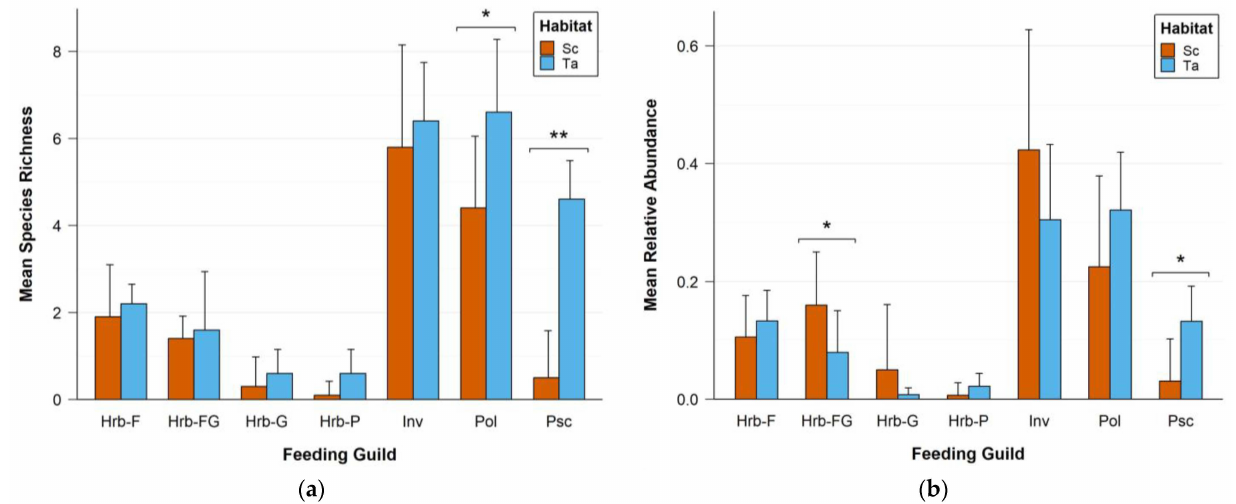
Figure 3. Comparison of ( a ) mean observed species richness and ( b ) mean relative abundance of the seven feeding guilds between the Sc and Ta habitats. For habitat and feeding guild labels, cf. Table 1. An asterisk represents a statistically significant difference between the two habitats (* for p -values < 0.05, ** for p -values < 0.01). Error bars represent the standard deviations.